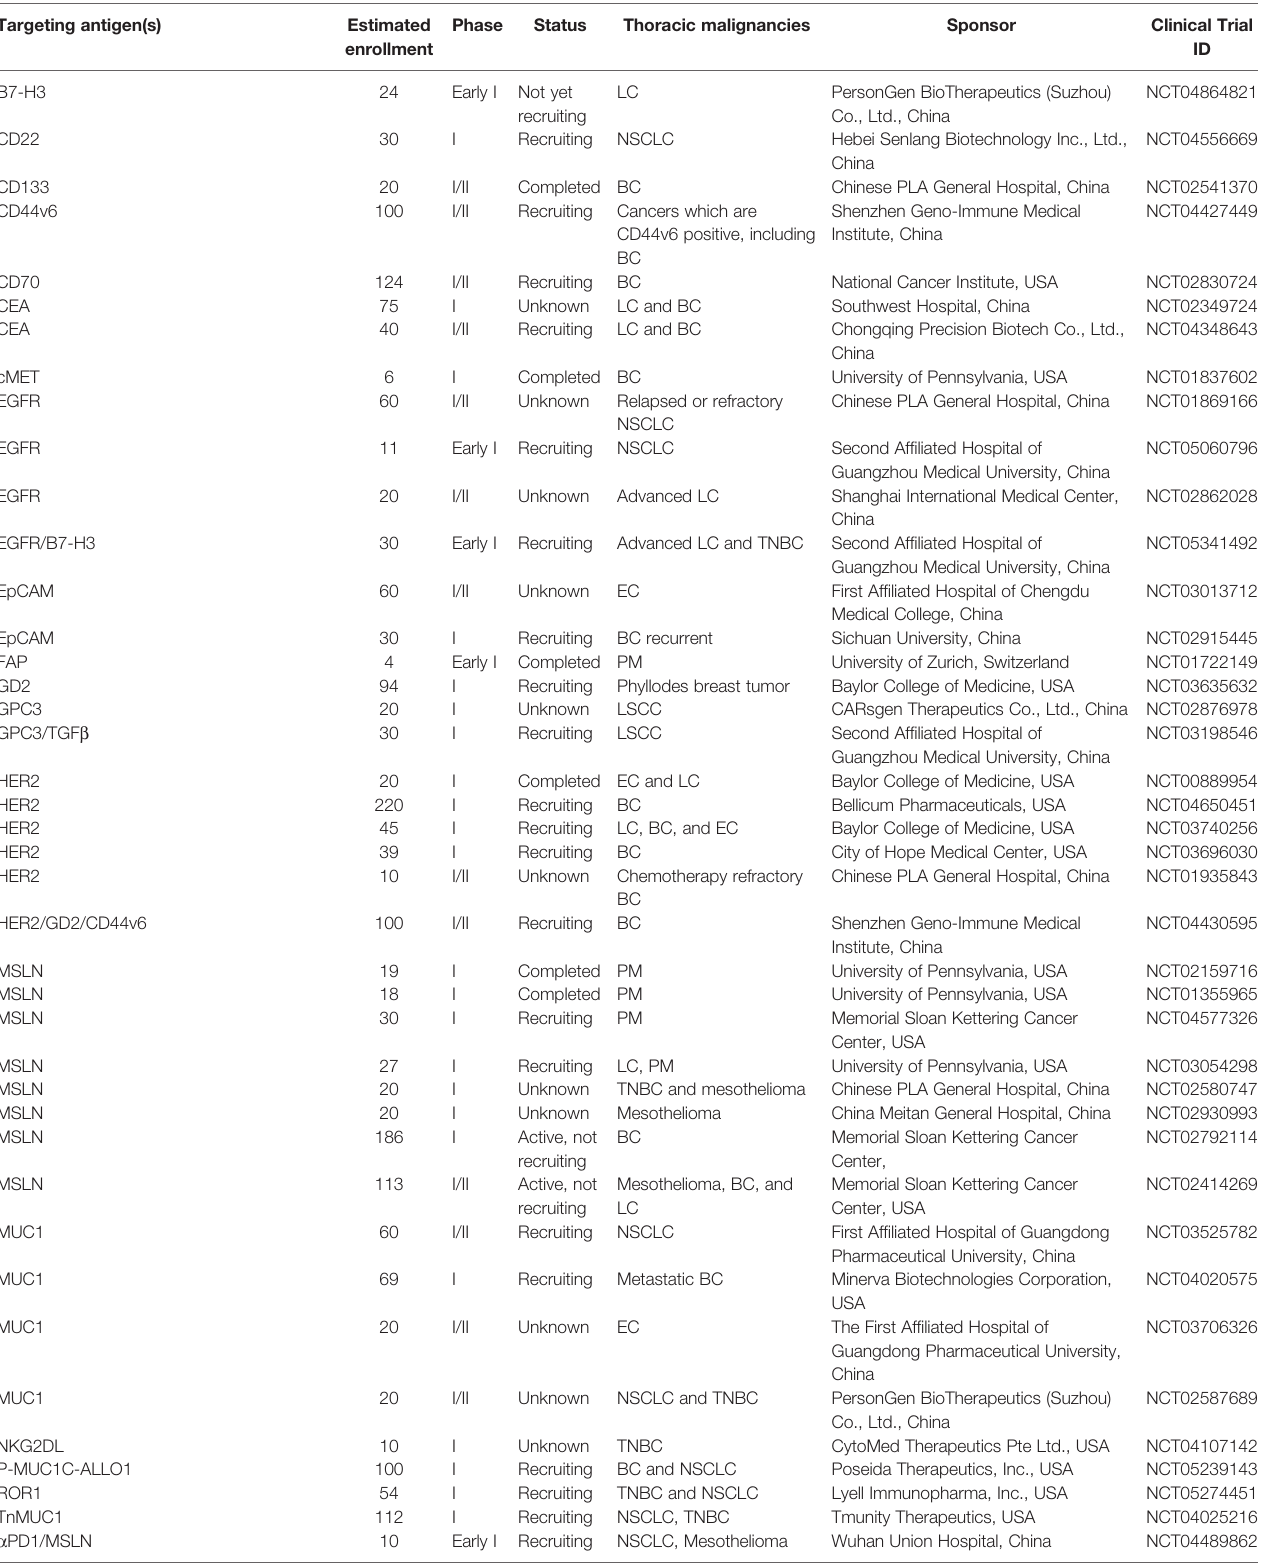
TABLE 1 | Ongoing clinical trials of CAR-T cell therapy for thoracic cancer in